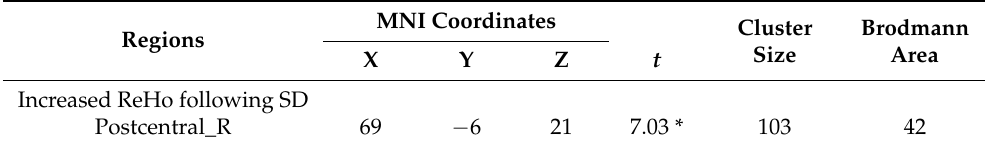
Table 2. Altered regional homogeneity following sleep deprivation.